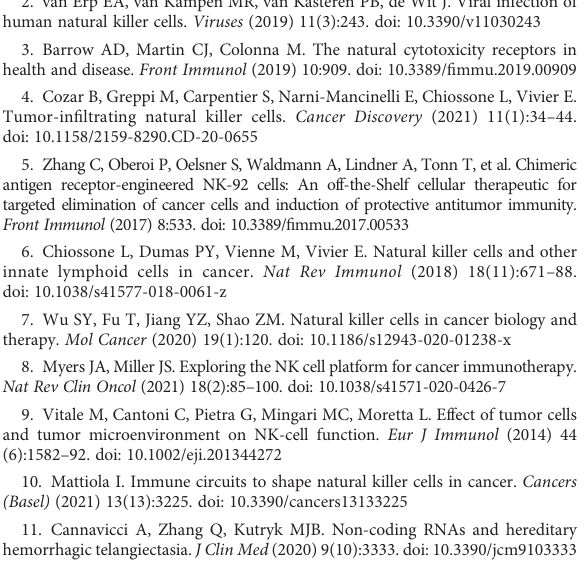
NCAL1-interacting target DNAs were isolated for quantitative real- time PCR. SUPPLEMENTARY FIGURE 5 Schematic diagram of NCAL1 discovery. NK cells were separated from total human PBMCs using an NK cell isolation kit, activated by IL-2 and IL- 15 for 24h, and treated with valproic acid for24 h. NKcells were collected and the RNAwas extracted. Next-generation sequencing (NGS) and qPCR were performed to obtain